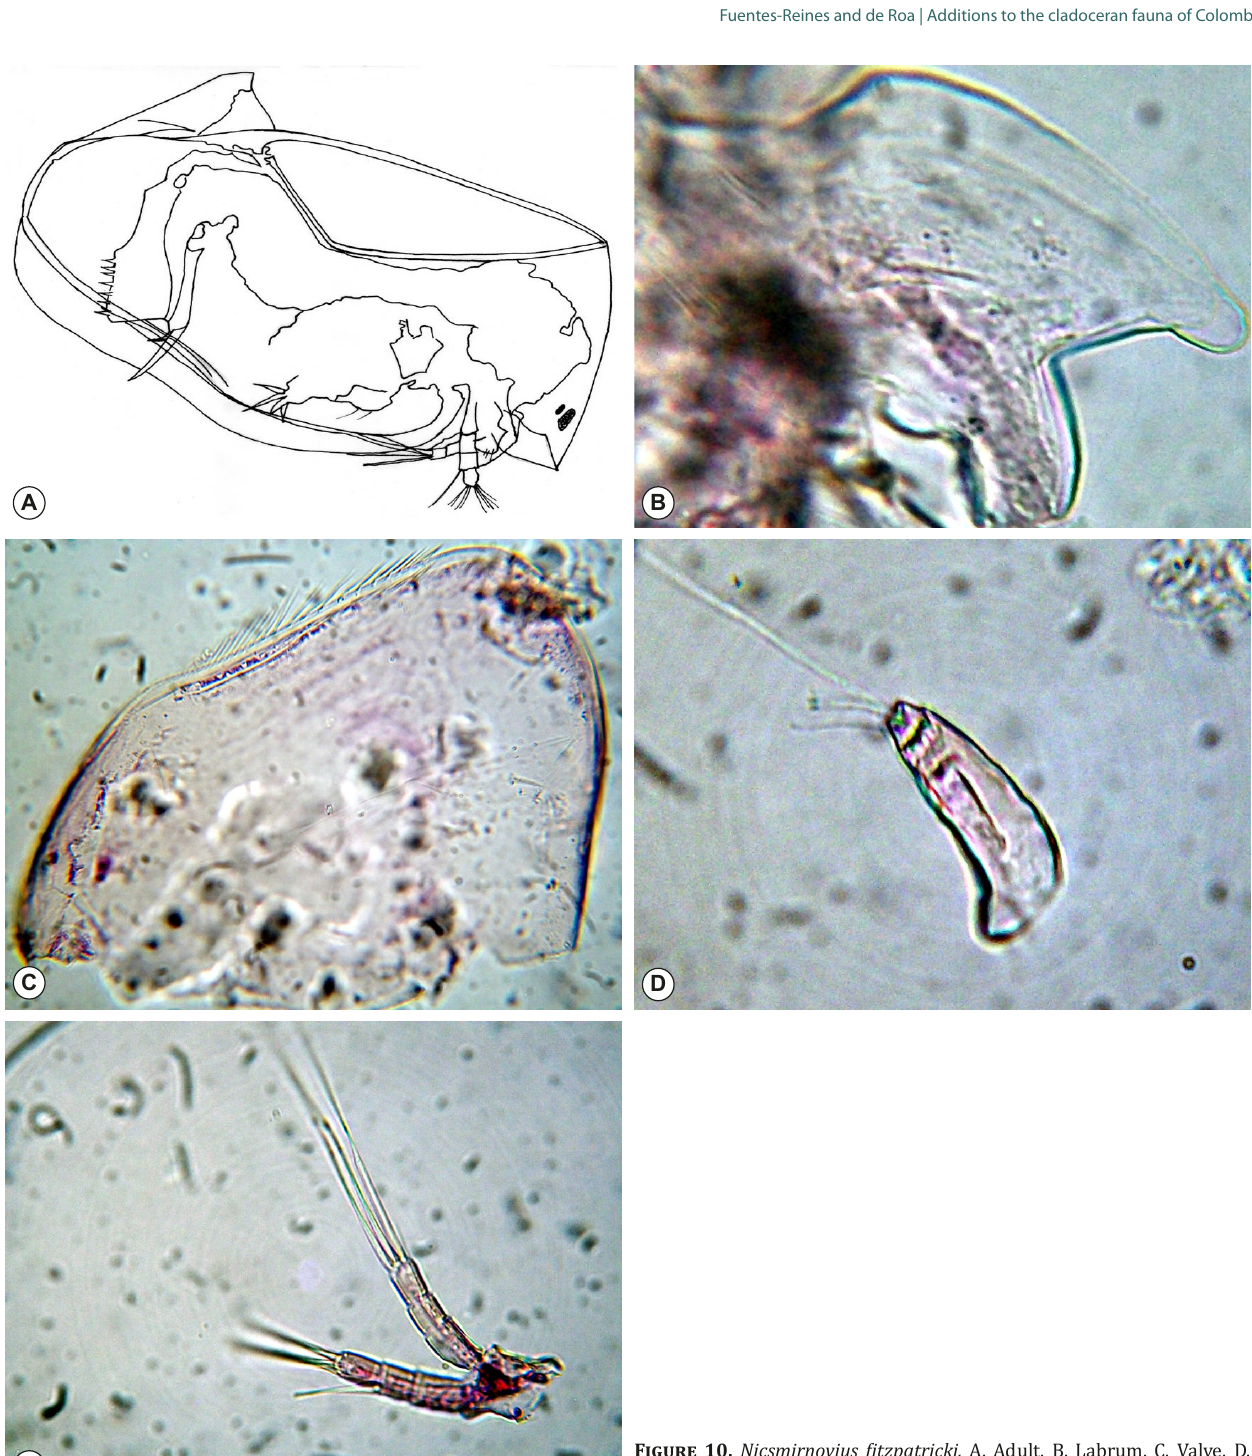
Figure 10. Nicsmirnovius